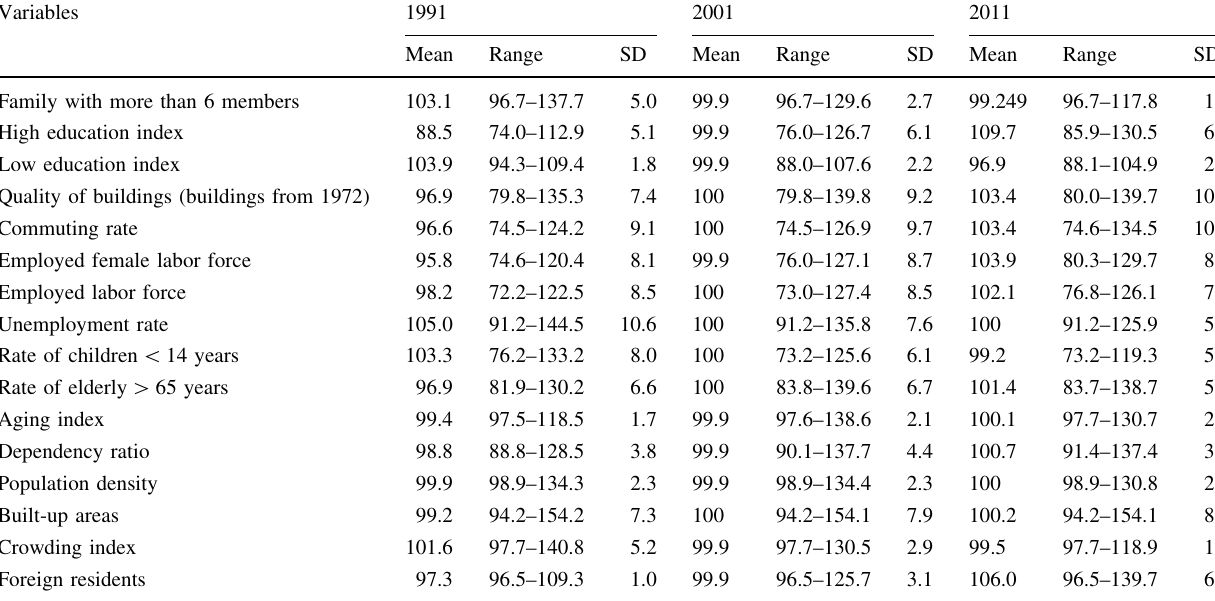
Table 2 Normalized values with the AMPI method for each indicator. Mean, range, and standard deviation are shown for each time period (1991, 2001, and 2011)